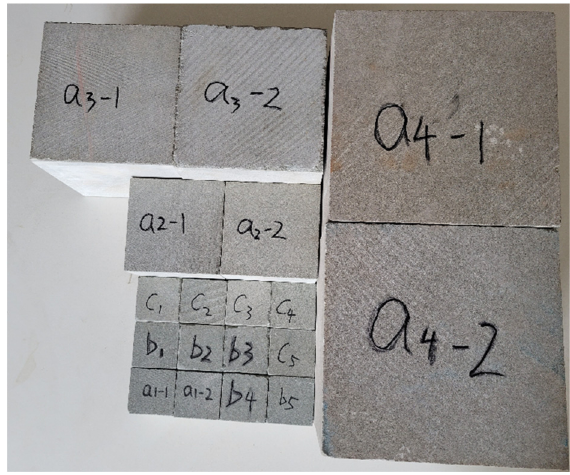
Figure 2. Sandstone samples.